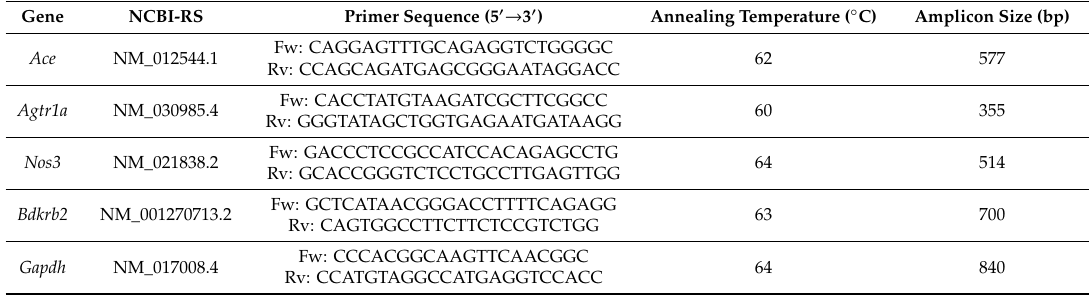
Table 2. Primer specifications and conditions used for semi-quantitative reverse transcriptase polymerase chain reaction.